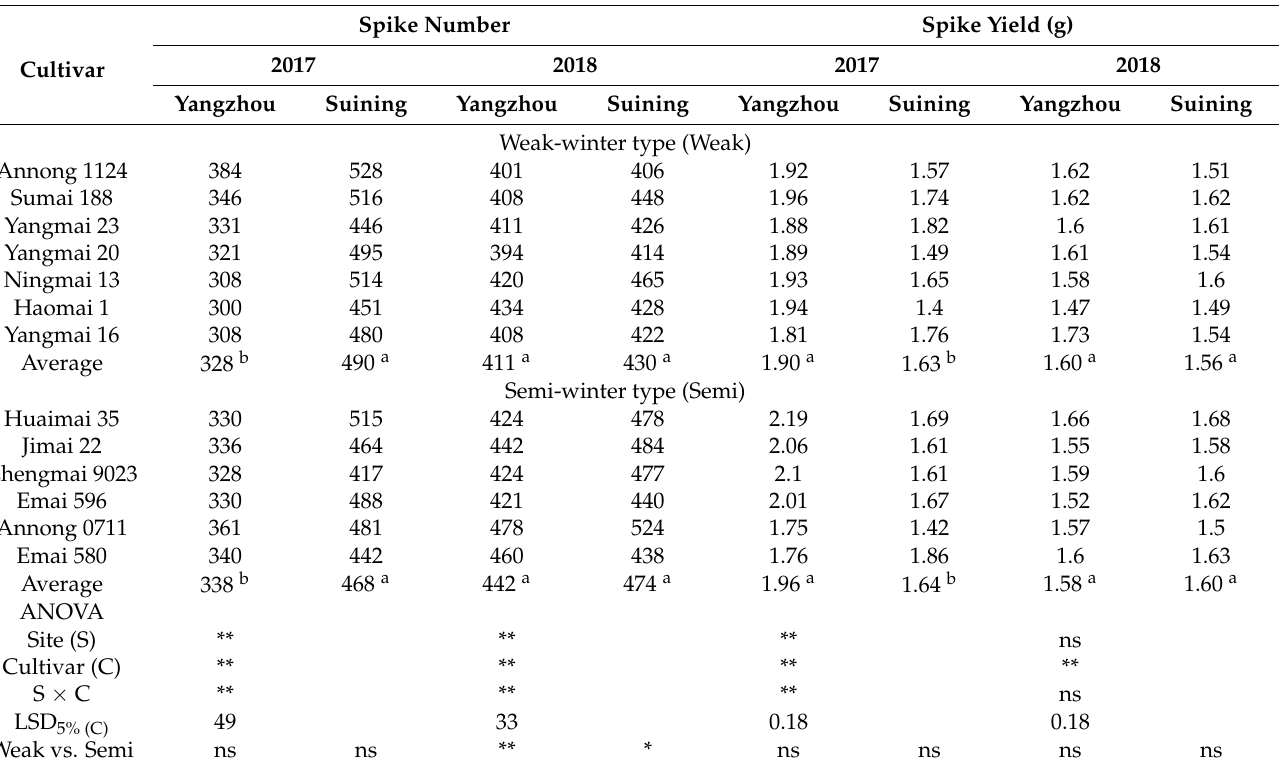
Table 4. Spike number and spike yield (g) of weak-winter-type and semi-winter-type cultivars planted in southern (Yangzhou) and northern (Suining) areas of the Yangtze River basin, China, in 2017 and 2018.